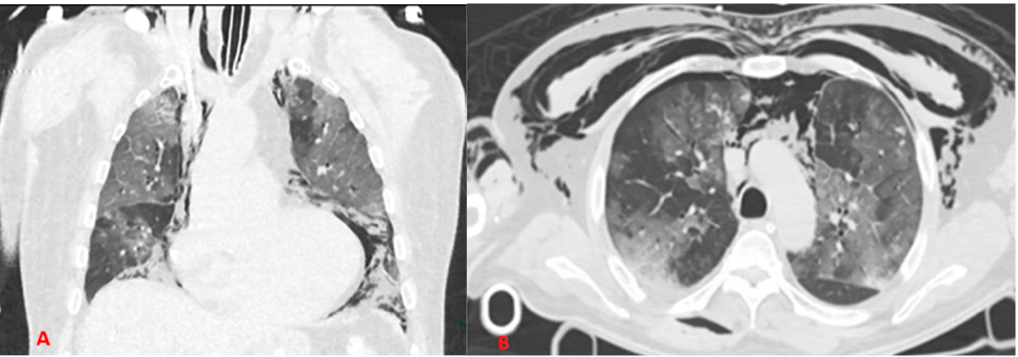
Figure 9. Examples of barotrauma: ( A ) coronal scans show pneumomediastinum associated with subcutaneous emphysema in COVID+ patient with ETT. ( B ) Axial scans show severe pneumomediastinum associated with pneumothorax and subcutaneous emphysema in COVID+ patient with CPAP.